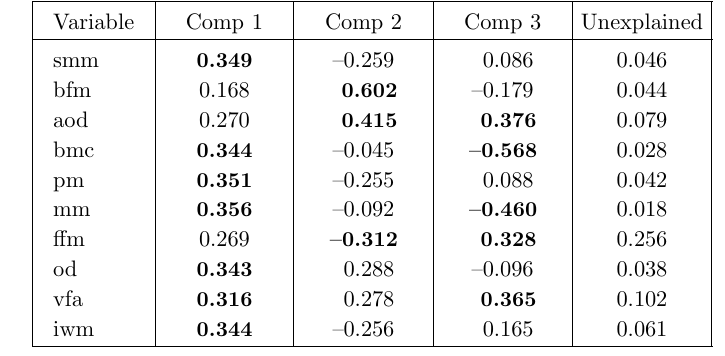
Table 9. Factor loadings for three principal